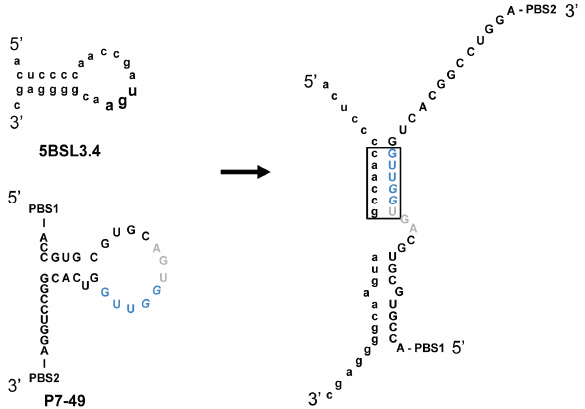
Figure 7. Theoretical model for the interaction between the 5BSL4 domain and the P7-49 RNA aptamer. CoFold and RNAup software were used to predict the nucleotides involved in the binding between the 5BSL4 stem-loop and the P7-49 aptamer. Residues proposed to initiate the kissing-loop interaction are boxed. Nucleotides belonging to groups 1 and 2 are colored as indicated in Figure 2. PBS, primer binding